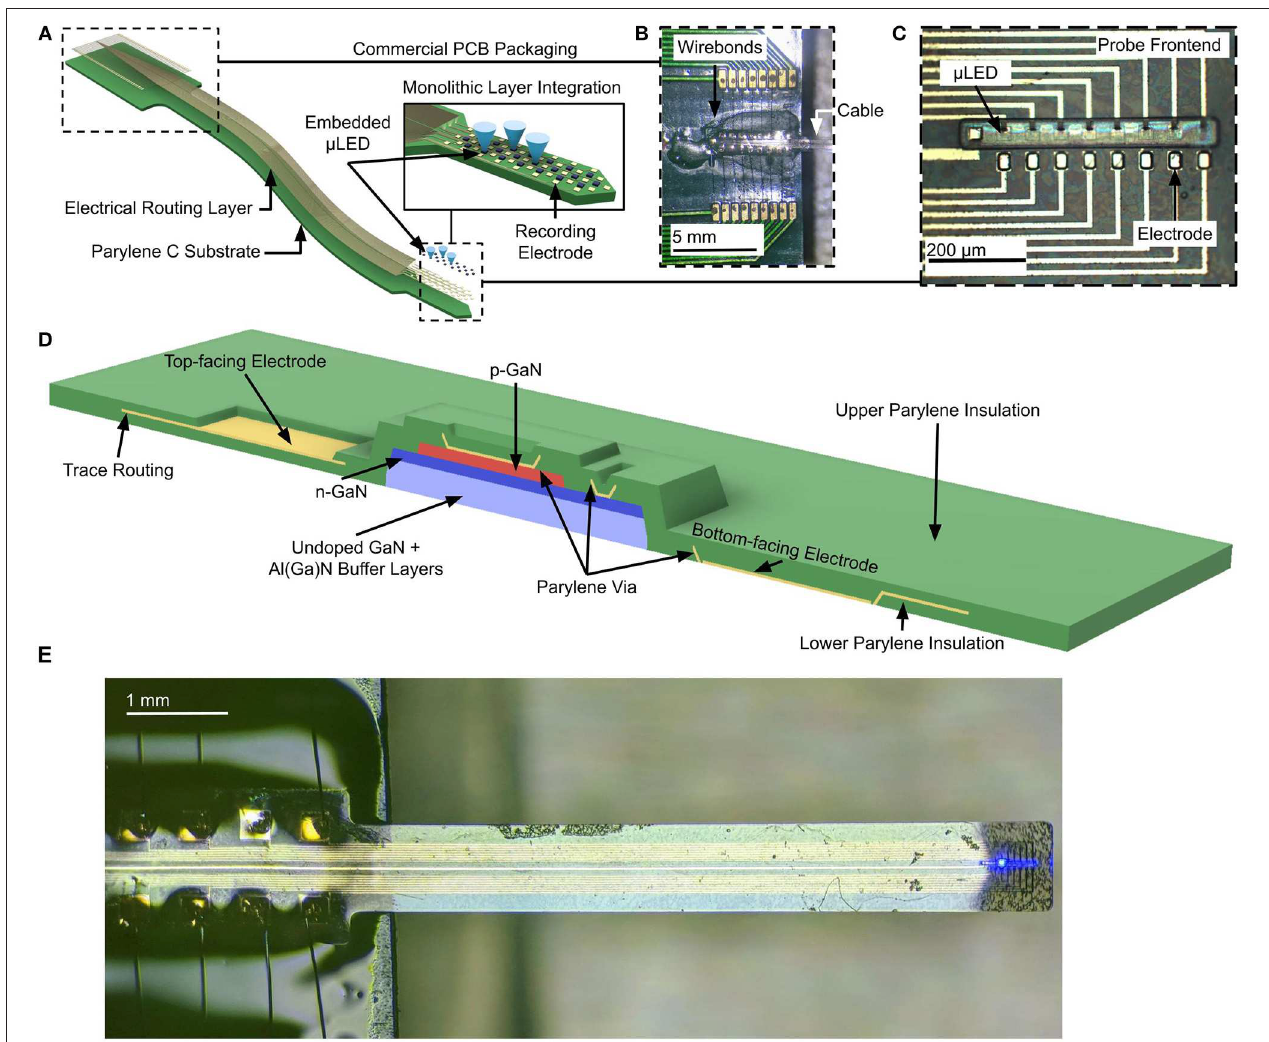
FIGURE 1 | (A) Schematic illustration of the probe architecture with a flexible Parylene C cable routing electrical traces from the device backend to the probe active region, containing µ LEDs and recording electrodes, (B) Packaging of probe backend with consumer PCB via wirebonding, (C) Active region of probe, featuring GaN µ LED array alongside backside recording electrodes, (D) Schematic cross-section of active region showing GaN µ LED mesa embedded in Parylene C insulation. The metal trace layer is entirely embedded in Parylene C; front- and backside electrodes are exposed by patterning the top or bottom layer of Parylene C. Traces are connected to GaN p -type and n -type contacts with vias though the Parylene C insulation. (E) Packaged neural probe with linear array active region and 7-mm cable, packaged with a consumer PCB and showing emission from GaN µ